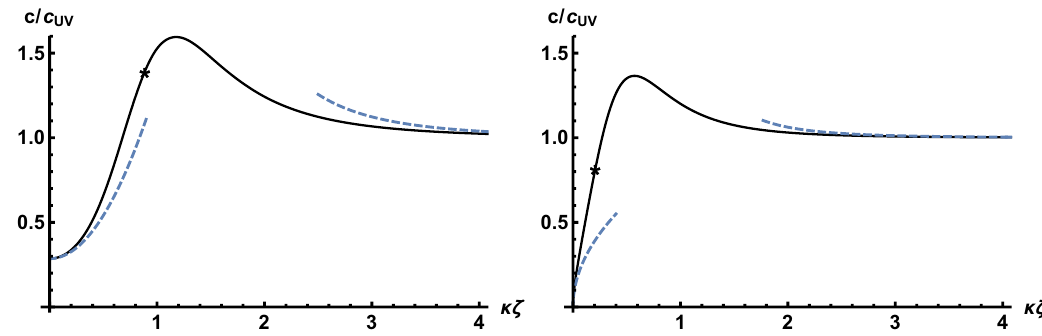
Figure 7 . Left: we depict c ( (cid:16) ) =c for a boomerang solution with n = 3 and m = 2 with Q f = 10. UV Right: we depict the same quantity for an anisotropic IR solution with n = 1 = 2 and m = 2 with Q f = 1. The dashed curves correspond to the analytic UV and IR asymptotics (3.51) and (3.52),